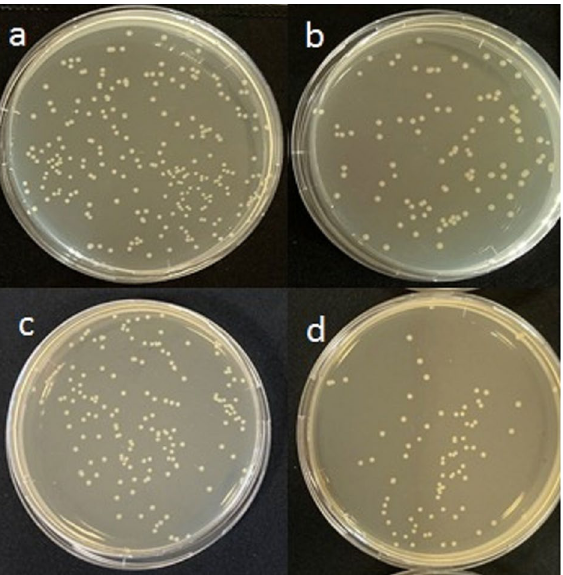
Figure 10. Reduction in microbial colonies after re-culturation in samples with the highest antibacterial activity on MAO-45-Ag: ( a ) E. coli viability after re-culture on bare Zr surfaces, ( b ) E. coli viability after